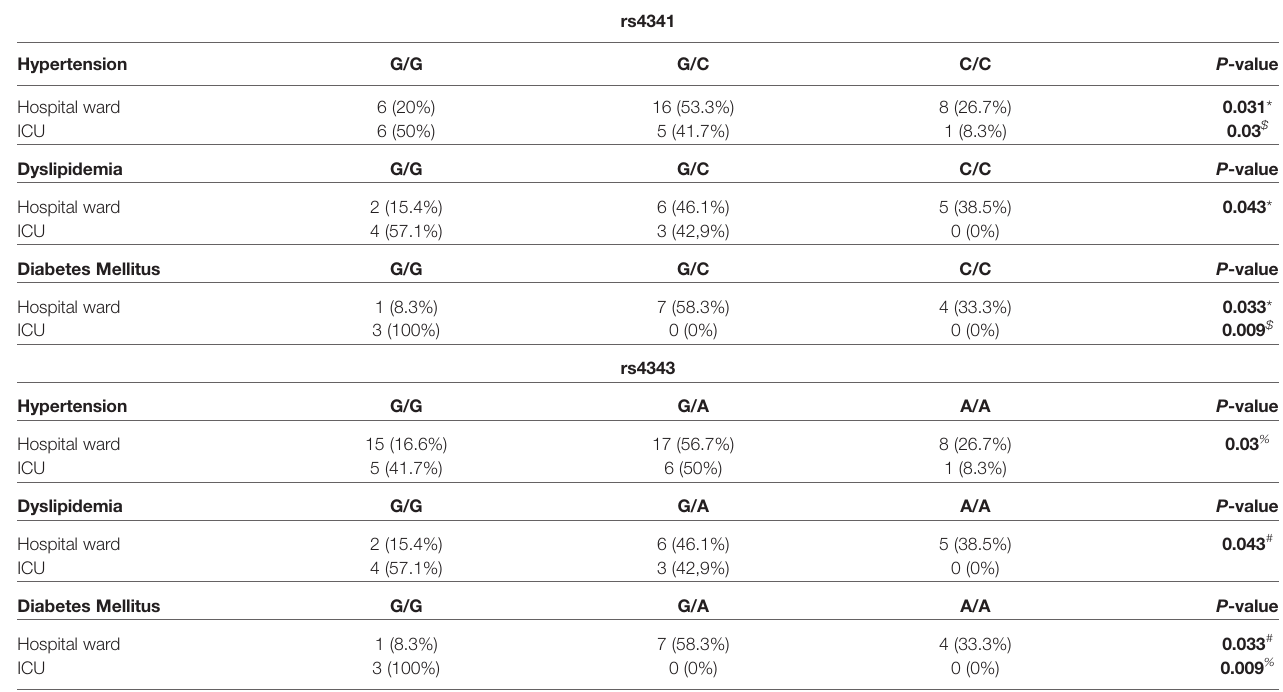
TABLE 2 | Genotype frequencies of rs4341 and rs4343 polymorphisms in COVID-19 patients according to its hypertensive, dyslipidemic or diabetic